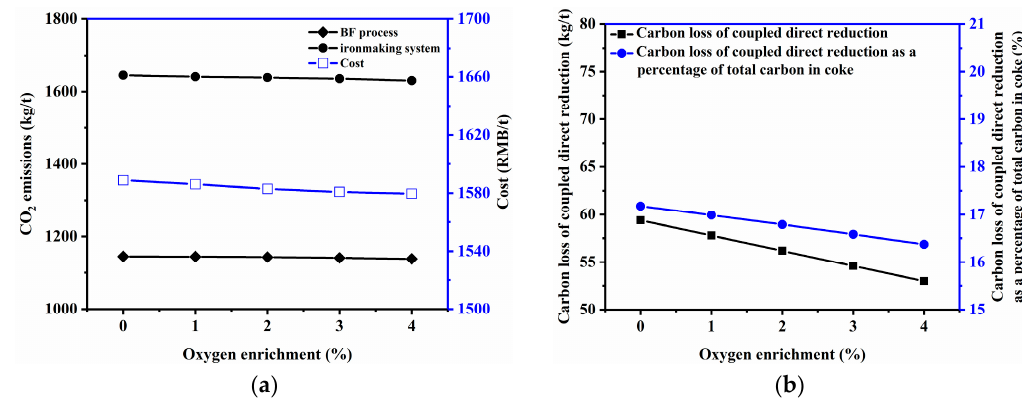
Figure 5. ( a ) Effect of oxygen enrichment rate on cost and CO 2 emissions; ( b ) Effect of oxygen enrichment rate on carbon loss of coupled direct reduction and its percentage of total carbon in coke.